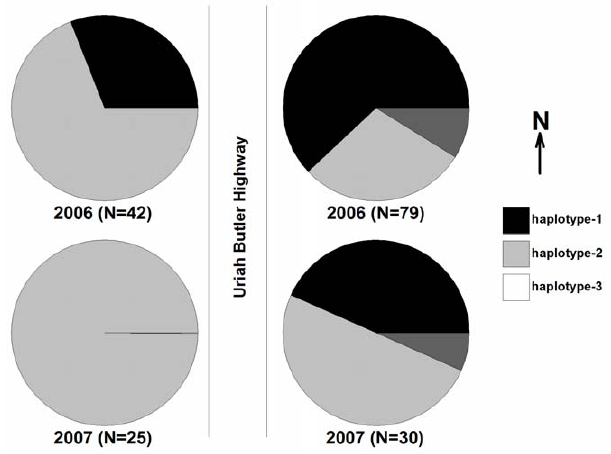
Figure 3. Frequency of unique COI mtDNA haplotypes recov- ered from the Charlieville neighborhood on the east and west side of Uriah Butler Highway in 2006 and 2007.